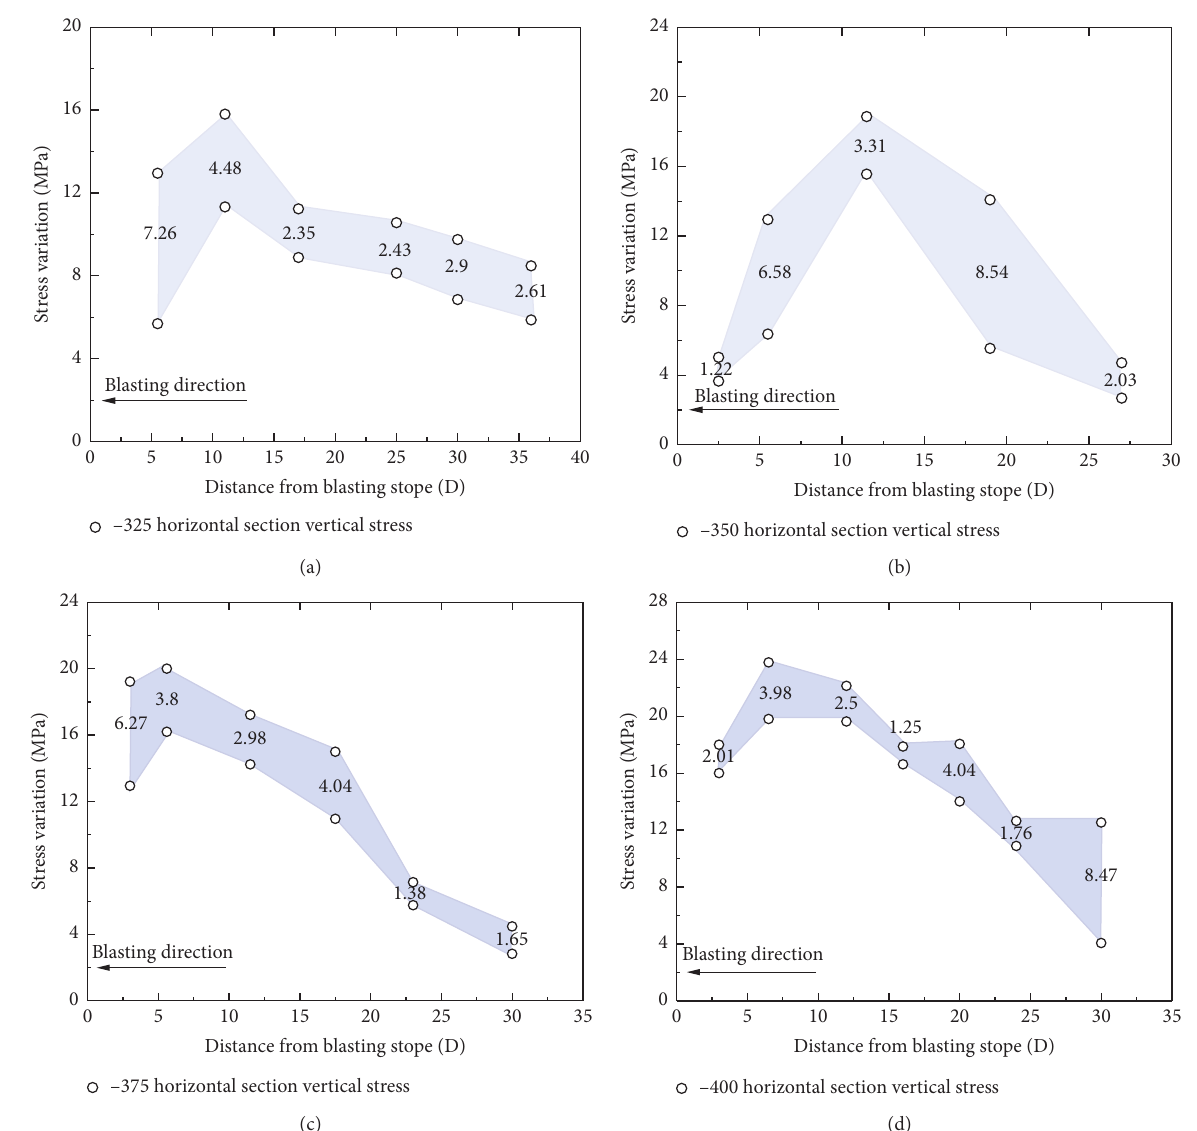
Figure 5: Stress jump of vertical stress under blasting. (a) − 325 horizontal section, (b) − 350 horizontal section, (c) − 375 horizontal section, and (d) − 400 horizontal